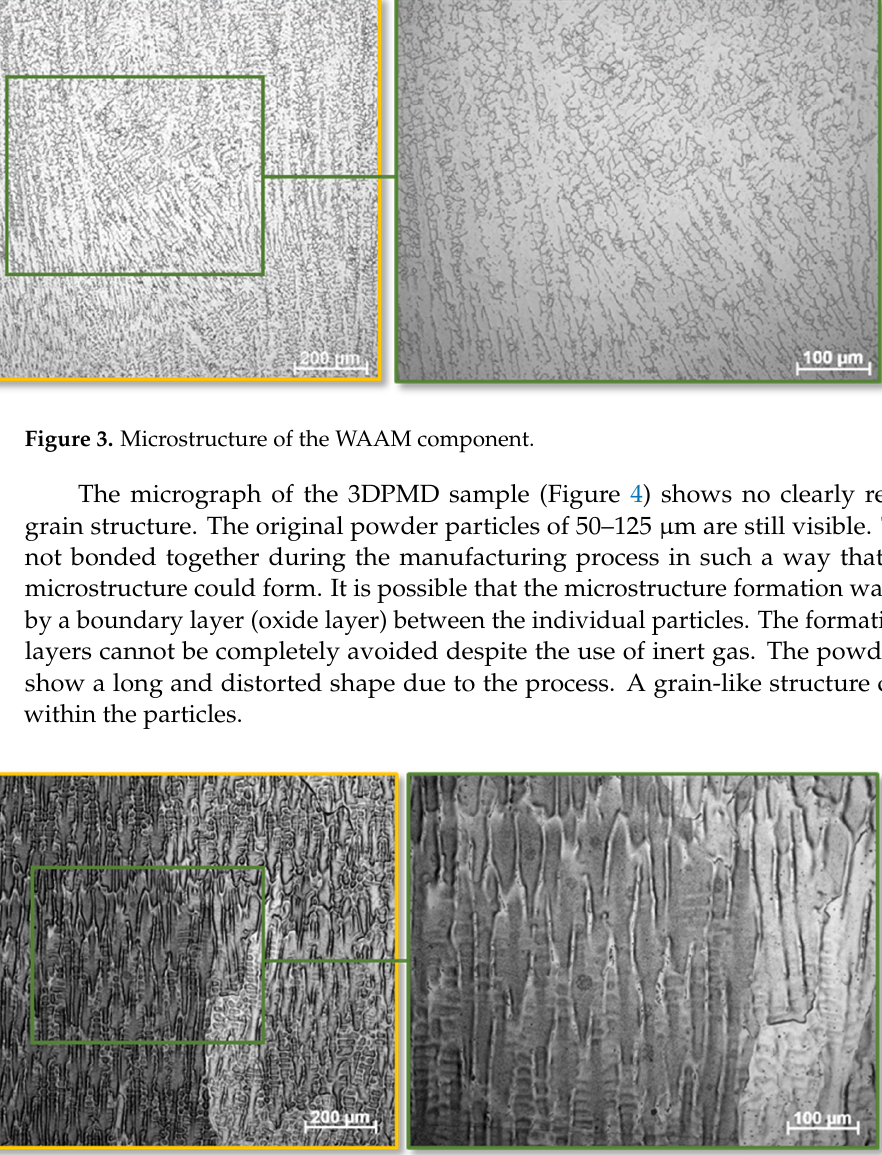
Figure 2. Microstructure of the SLM component.